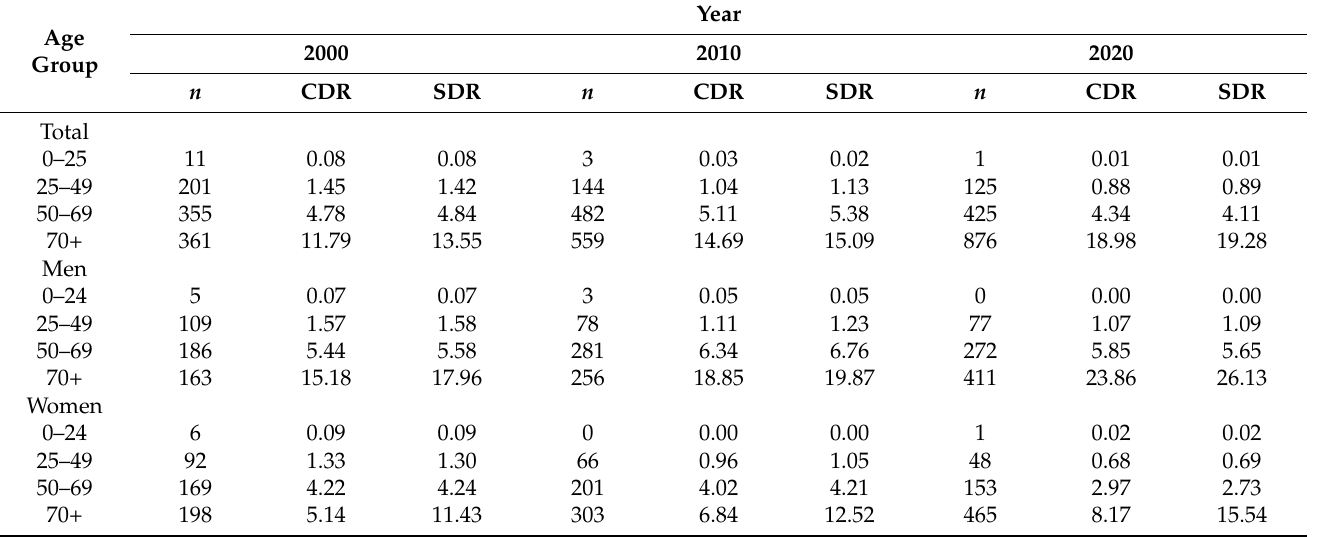
Skin melanoma-related mortality increased with age (Table 5). From 2000 to 2020, in Poland, the values of death rates per 100,000 population were on the increase. In 2000 and 2020, the crude death rates (CDRs) calculated per 100,000 population were 2.43 and 3.73, respectively. During this period, the annual growth rate of CDR values was 2.8% (APC = 2.8; 95% CI: 2.4–3.2; p < 0.05). Both male and female groups demonstrated a noticeable increase in death rates: from 2.50 to 4.11 (APC = 3.2; 95% CI: 2.7–3.7; p < 0.05) in the male group and from 2.36 to 3.38 in the female group (APC = 2.4; 95% CI: 2.0–2.9; p < 0.05) (Tables 2–4 and 6). Table 5. Number of deaths, CDR values and SDR values due to skin melanoma by age and sex in Poland in 2000, 2010 and